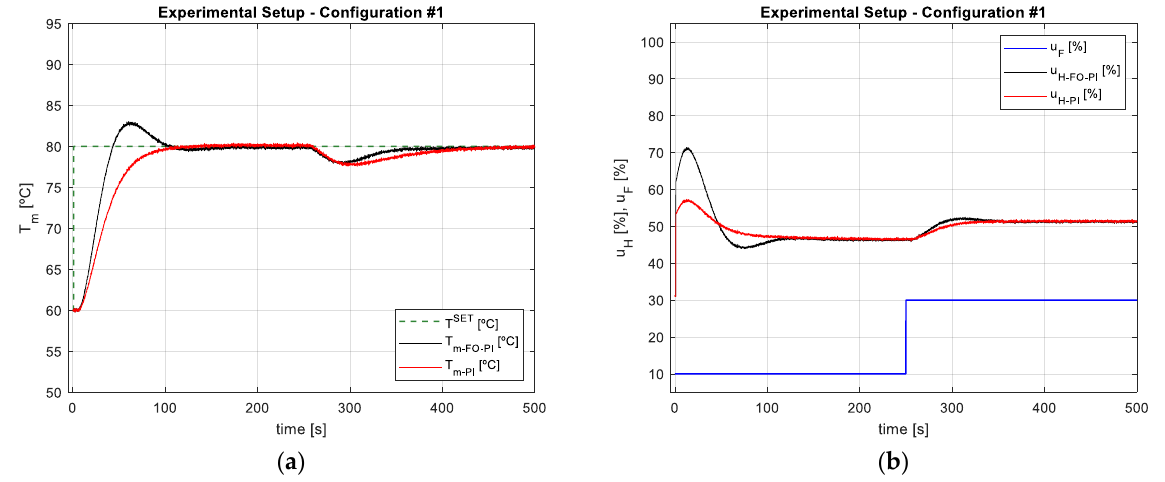
Figure 21. Closed-loop microprocessor-based experimental results for servo and regulatory control, considering a PI and a fractional-order PI controller: ( a ) Temperature in the heat block; ( b ) control signal u H and disturbance u F .